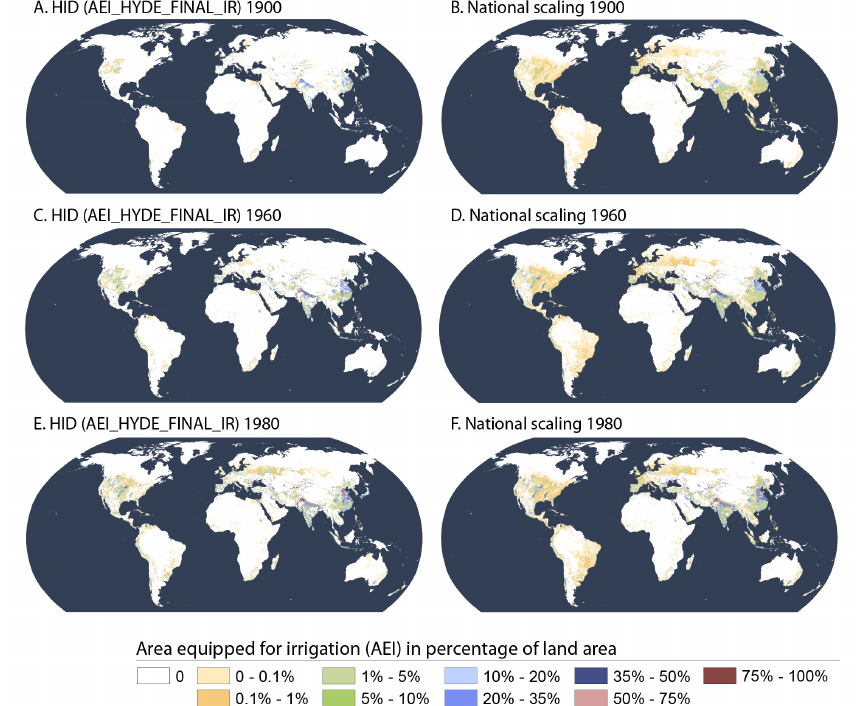
Figure 7. Comparison of the historical irrigation data set (HID) (developed using HYDE land cover, central estimate; AEI_HYDE_FINAL_IR) (a, c, e) to irrigation maps developed by multiplying area equipped for irrigation (AEI) in year 2005 with scaling factors derived from historical changes of AEI at country level (b, d, f) for years 1900 (a, b) , 1960 (c, d) and 1980 (e, f)